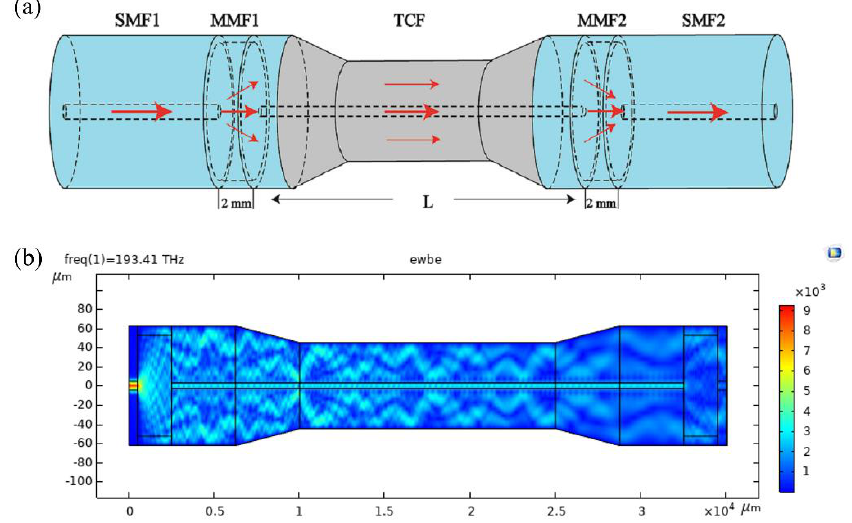
Figure 1. ( a ) Schematic of the proposed MZI with a multimode-fiber-thin core-fiber-multimode-fiber (MMF-TCF-MMF) structure. ( b ) Simulated result of the mode field distribution.